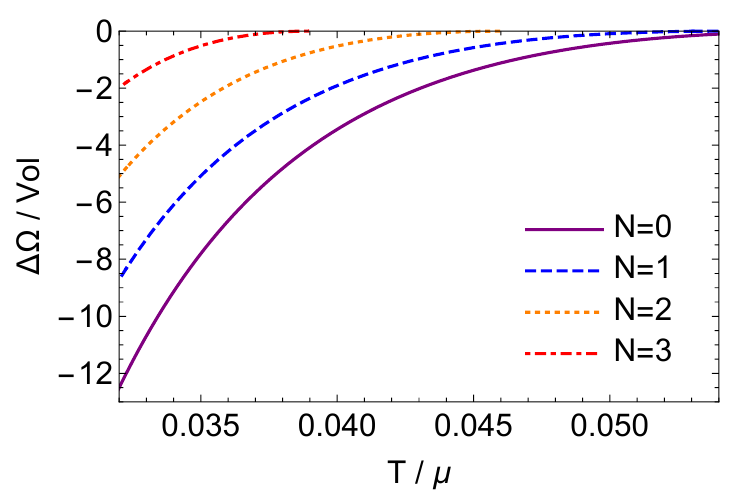
Figure 10 . The thermodynamic potential that has each number of nodes. N is the number of